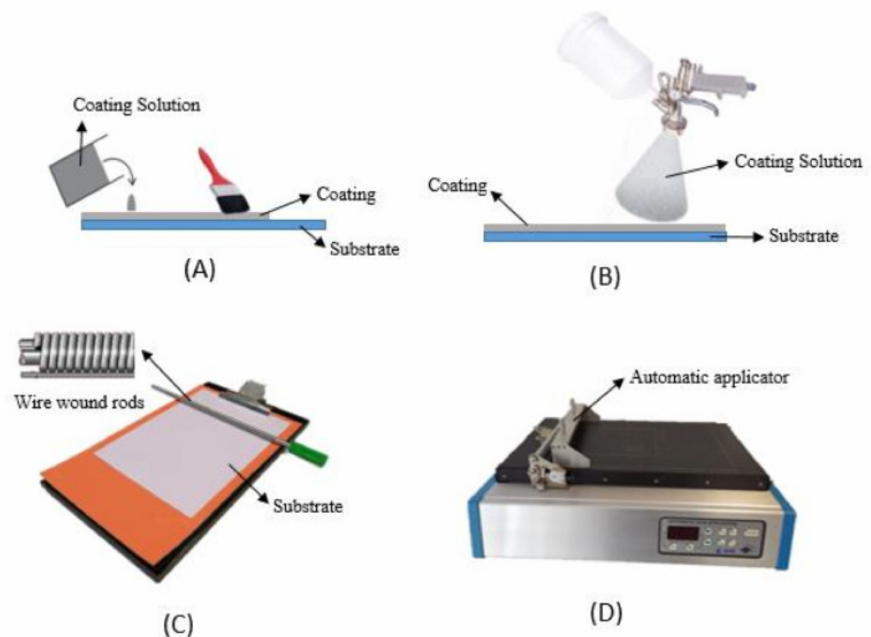
Figure 5. Techniques used to apply the actives coatings: ( A ) brushing, ( B ) spraying, ( C ) manual coater, and ( D ) automatic coater (or plate stripe